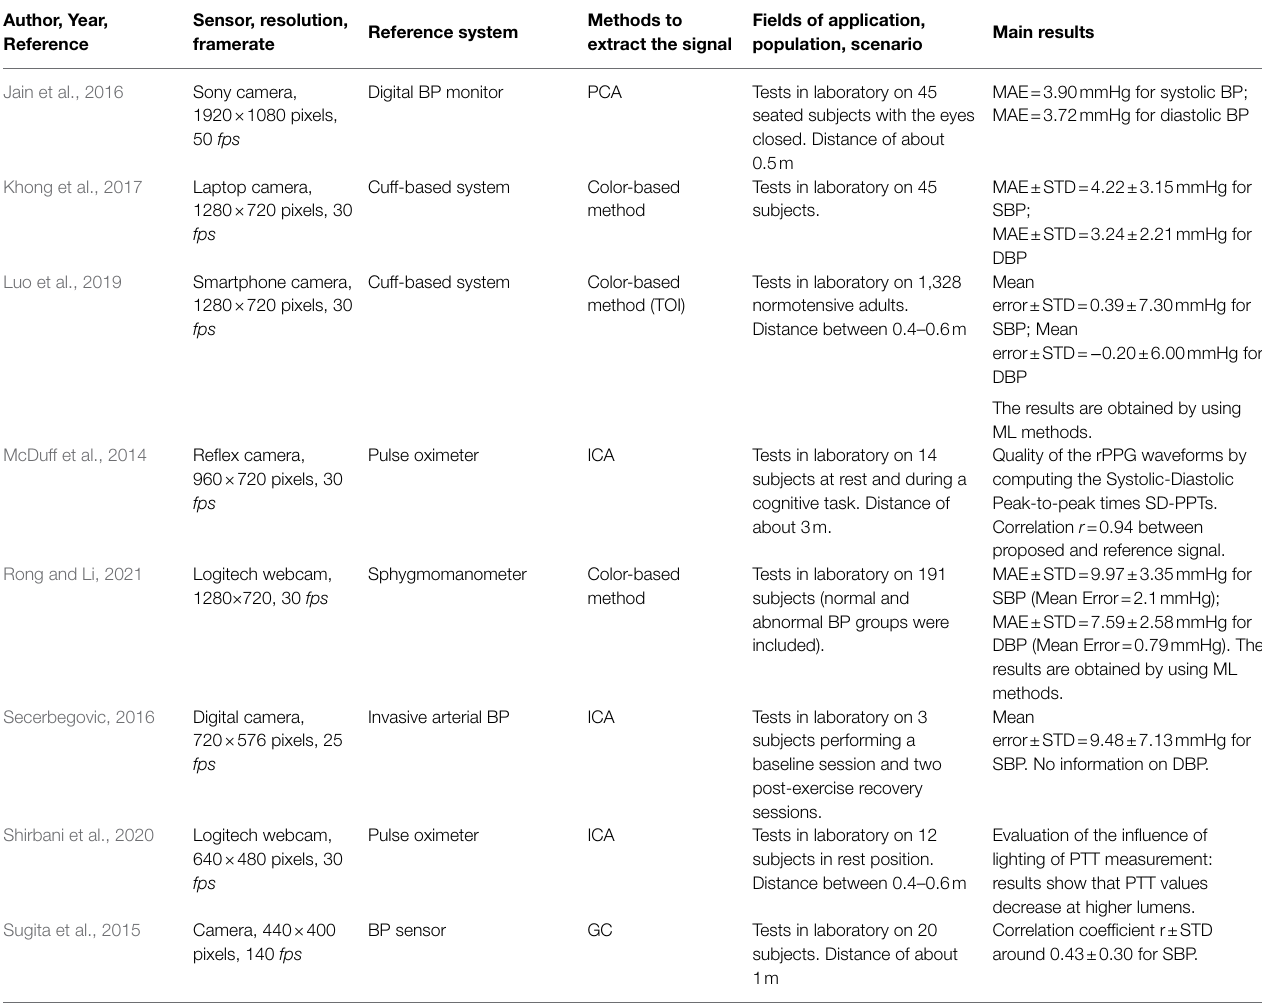
TABLE 4 | Studies using digital cameras for estimating BP in different fields of